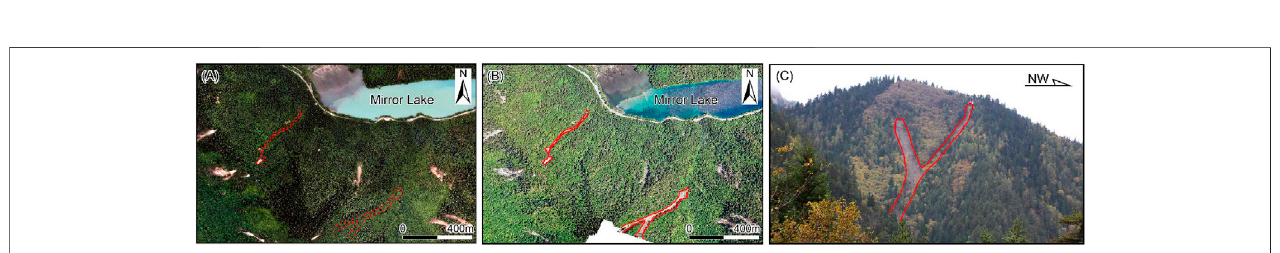
FIGURE 9 | Post-seismic landslide (A) Slope in 2017 (B) Post-seismic landslide in 2020 (C) Field photo showing the post-seismic landslide.